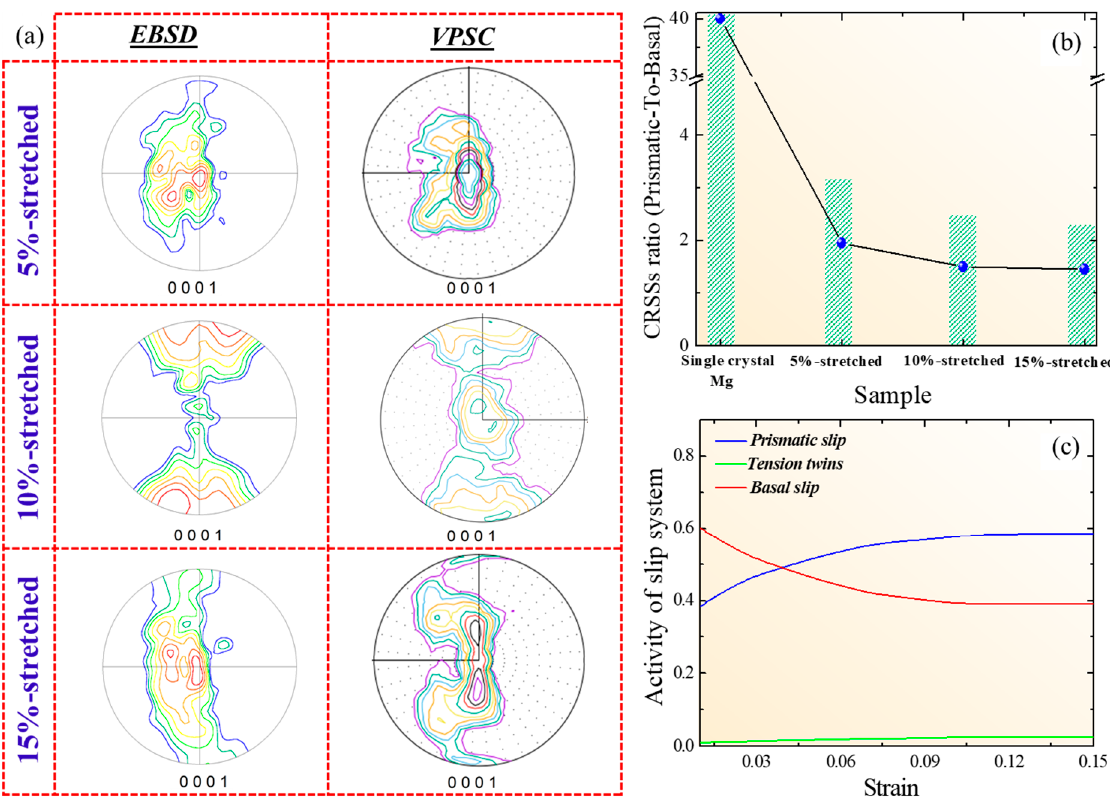
Figure 2. ( a ) Inverse pole figure maps and related 0001 pole figures of the AZ31-Ca Mg alloy samples stretched to 5%, 10% and 15%. ( b ) and ( c ) grain size and misorientation profile of the stretched alloy samples, respectively.